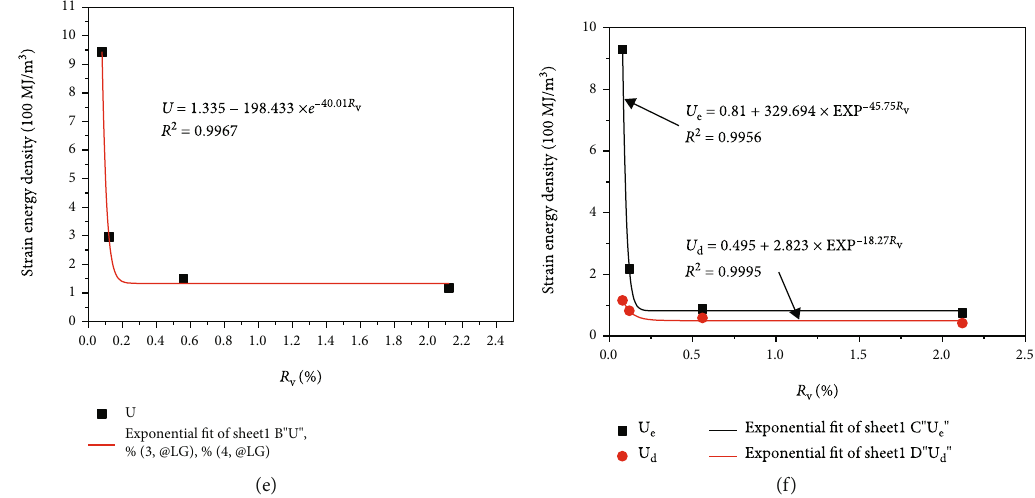
U e , d , and relative cycle for granite having di